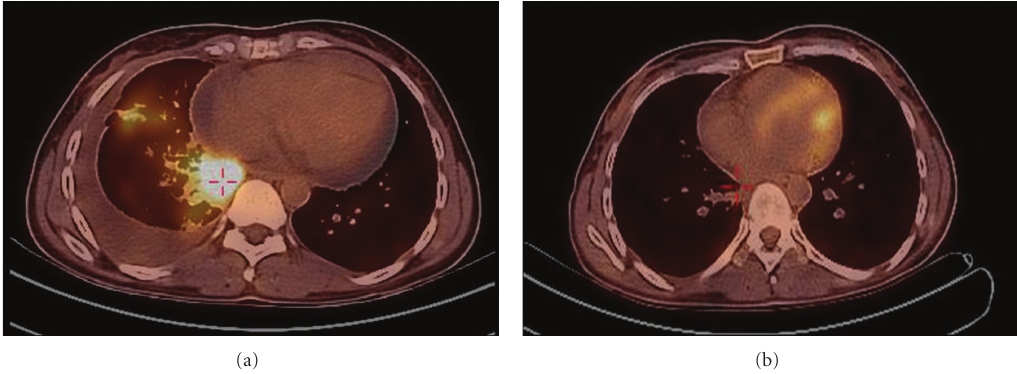
Figure 1: A woman, 39, never-smoker, developed adenocarcinoma of the right lower lobe, T4 N2 M1b with metastases in bone and liver. 18F-FDG PET-CT before treatment (a) and after 4 months (b). Complete remission was confirmed also a year later.